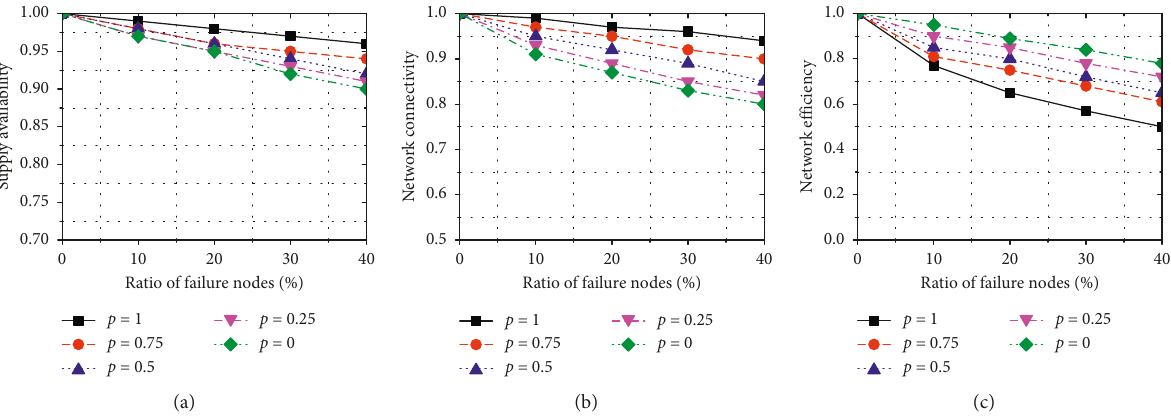
Figure 7: Military Logistic Network under random disruption. (a) Supply availability. (b) Network connectivity. (c) Network